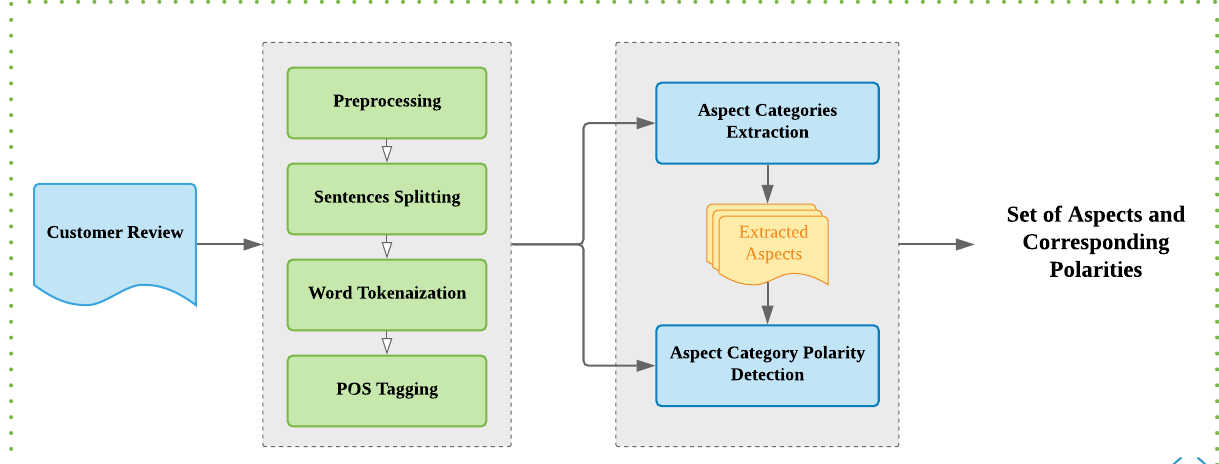
Figure 3. The architecture of the ABSA